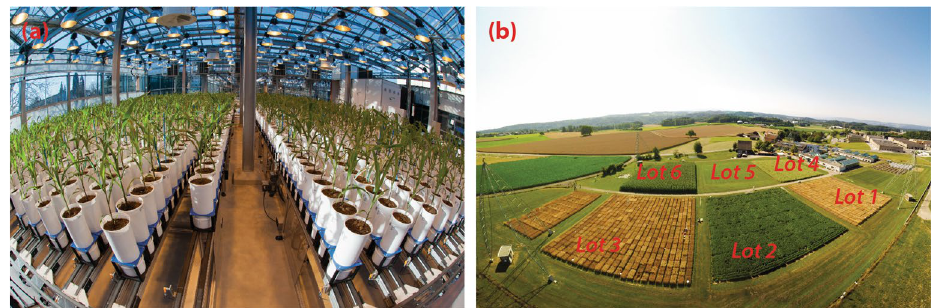
Figure 1. Overview of the two high-throughput phenotyping platforms. ( a ) PhenoArch platform at INRAE Montpellier (image source: INRAE). ( b ) FIP platform at ETH Zürich (image source: ETH crop